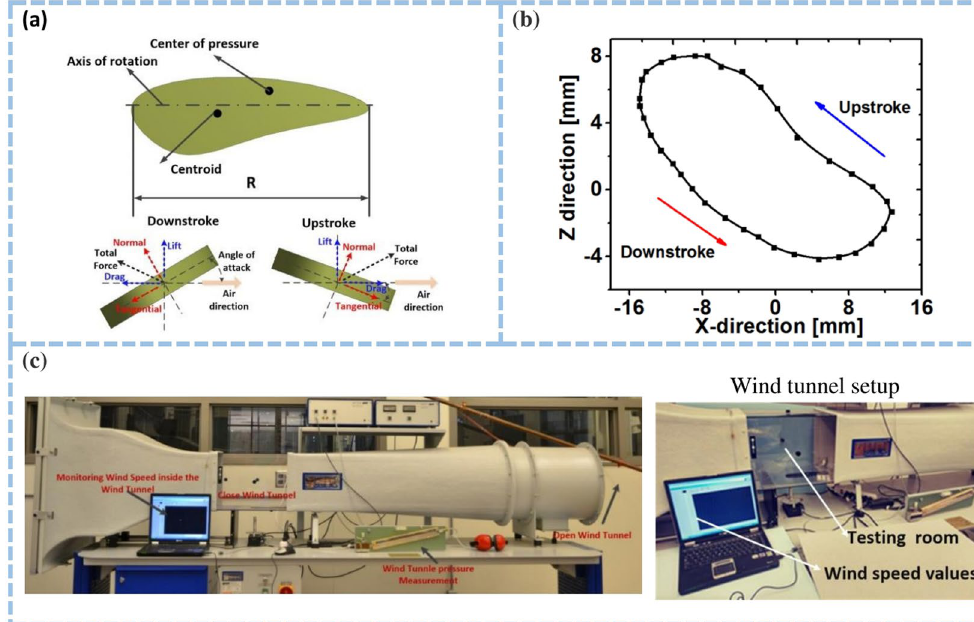
Figure 2. Wing aerodynamics modeling and experimental setup. ( a ) Wing geometry parameters and components of the total aerodynamic force in upstroke and downstroke. ( b ) The averaged trajectory of the wing tip in the XZ-plane. ( c ) Measuring setup inside the closed system wind tunnel while monitoring the wind speed values and the wind